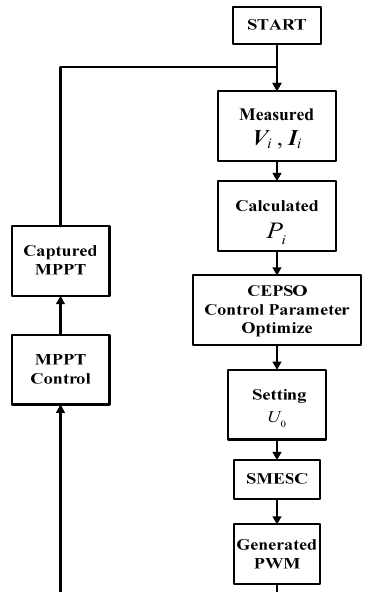
Figure 12. Proposal based on SMESC of CEPSO for the MPPT flowchart.